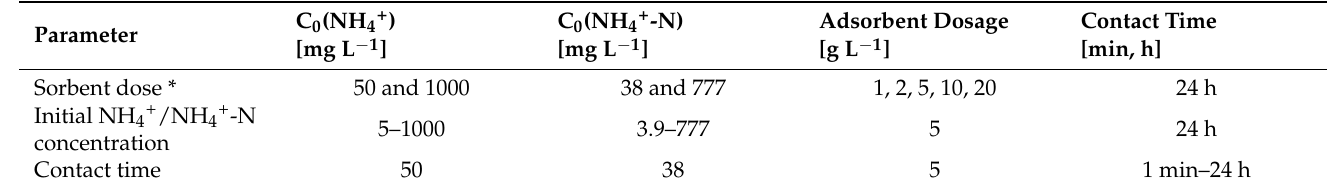
Table 3. Target parameters used in the batch sorption experiments. All experiments were performed